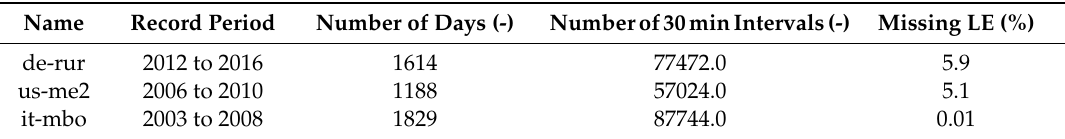
Table 1. Missing values for the three